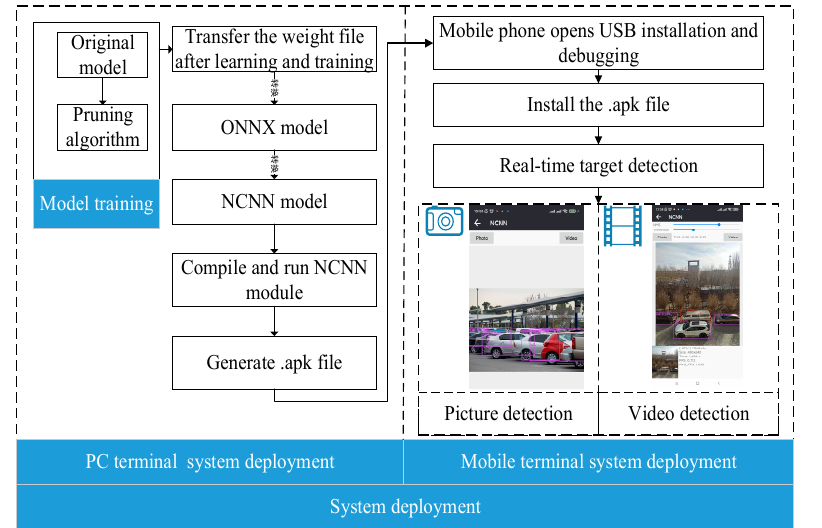
Figure 7. System deployment diagram.